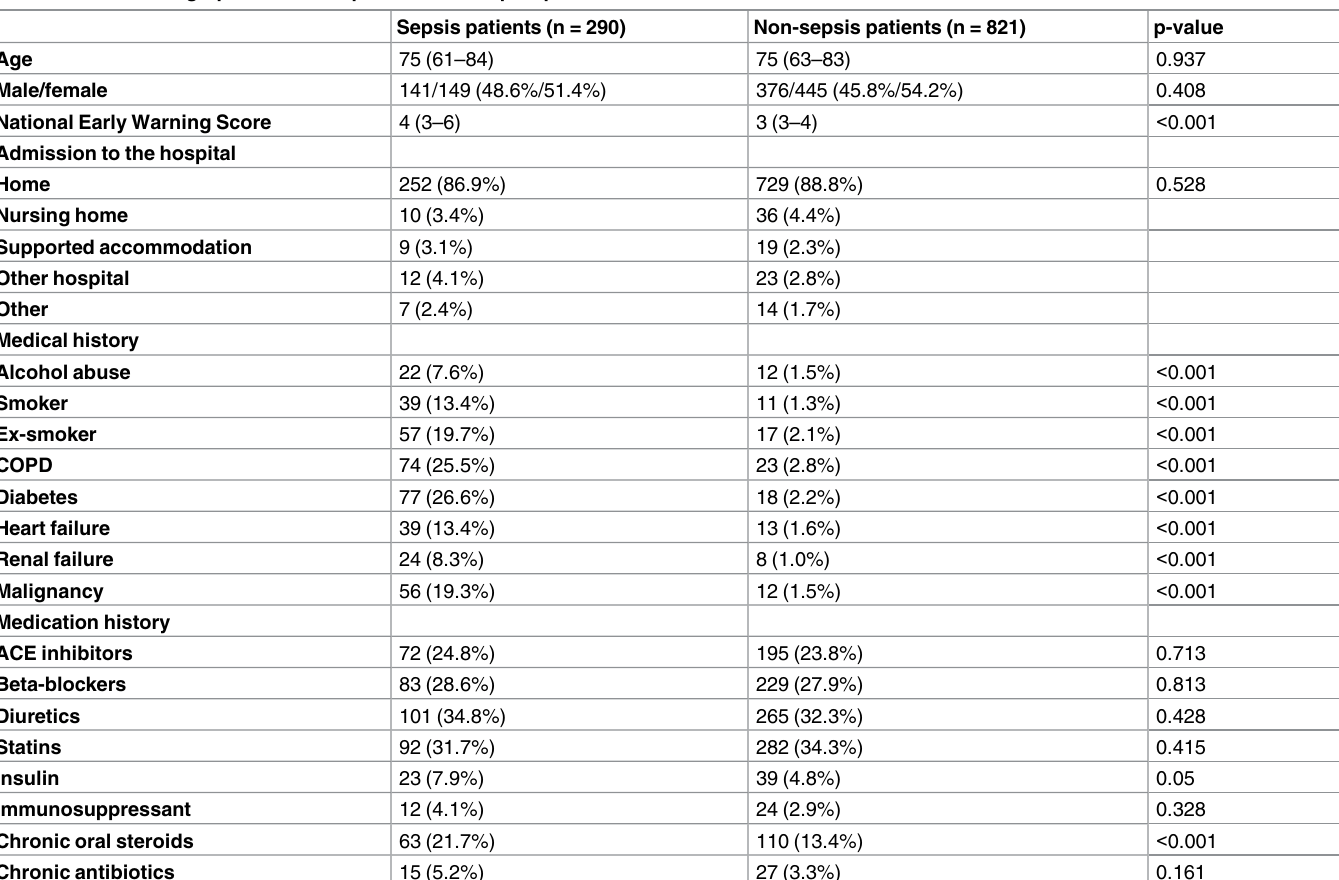
Table 1. Basic demographic data of sepsis and non-sepsis patients